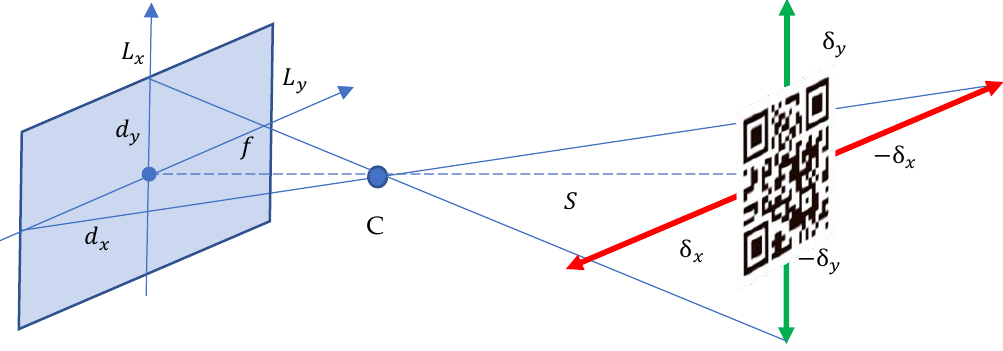
Figure 11. The relationship between camera parameters and size of ground coverage.